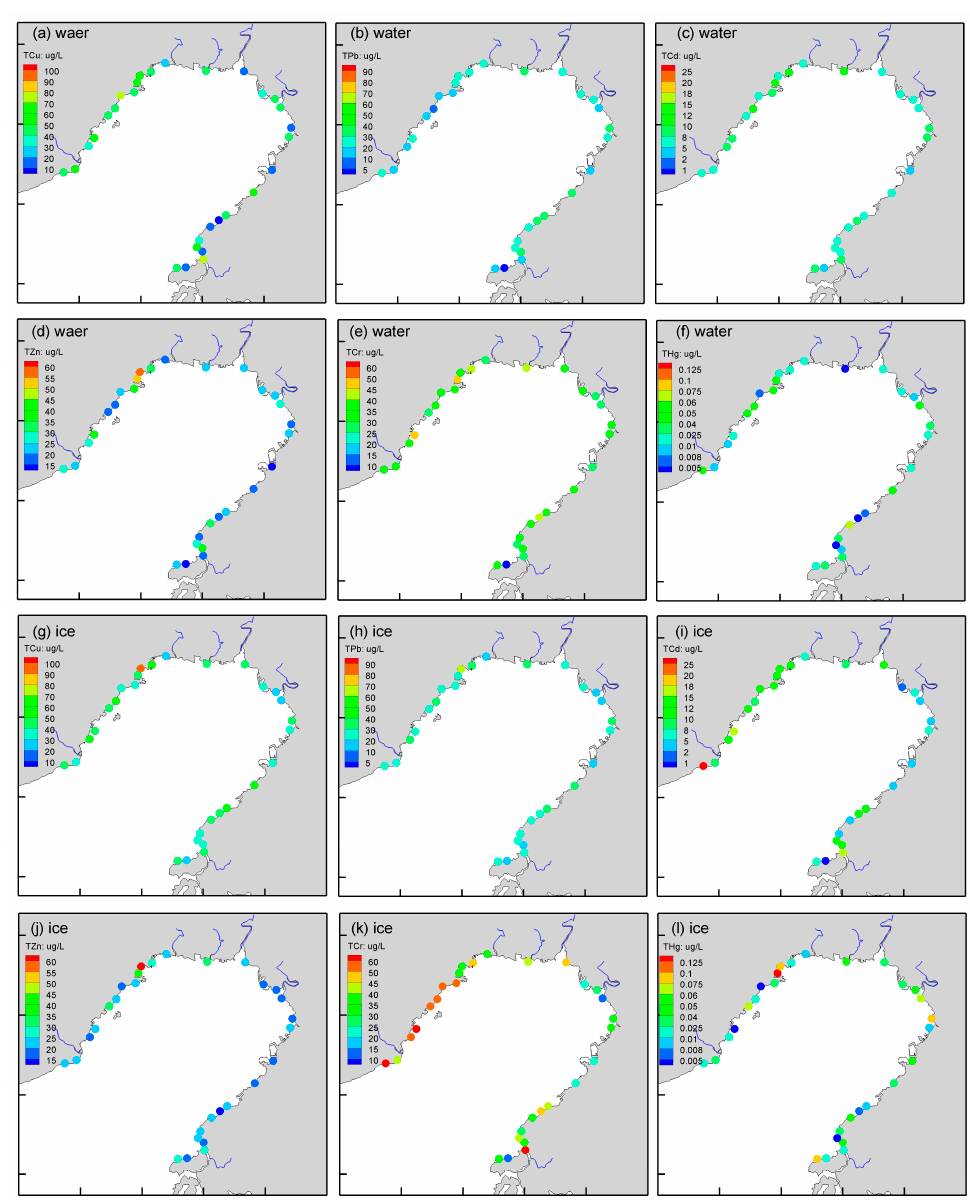
Figure 2. Spatial distribution of trace metals in water and ice around Liaodong Bay. ( a ) TCu in seawater; ( b ) TPb in seawater; ( c ) TCd in seawater; ( d ) TZn in seawater; ( e ) TCr in seawater; ( f ) THg in seawater; ( g ) TCu in ice; ( h ) TPb in ice; ( i ) TCd in ice; ( j ) TZn in ice; ( k ) TCr in ice; ( l ) THg in ice.